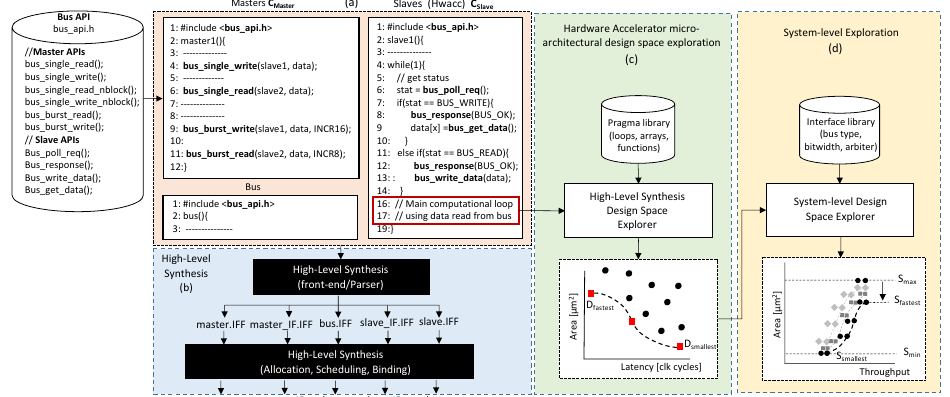
Figure 4. Example of synthesizable communication APIs (one master and one slave) and the HLS DSE flow to optimize the micro-architecture of the slave (hardware accelerator). ( a ) Behavioral descriptions for individual components of SoC. ( b ) Result of individual HLS of each component. ( c ) Individual component HLS design space exploration. ( d ) System-level exploration by combining different micro-architectures of each individual component.